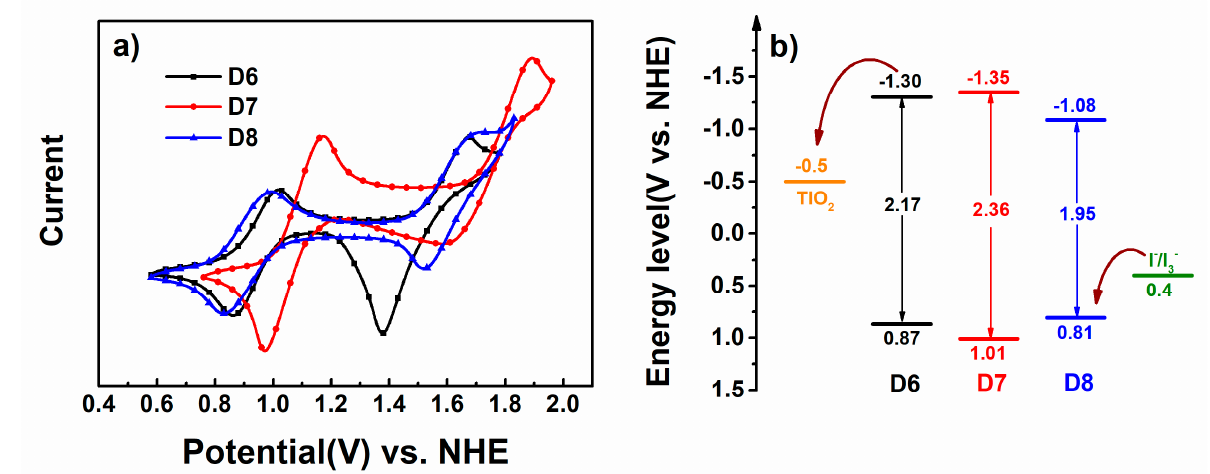
Figure 3. ( a ) Cyclic voltammograms of the dyes. ( b ) The energy level diagram of the dyes.